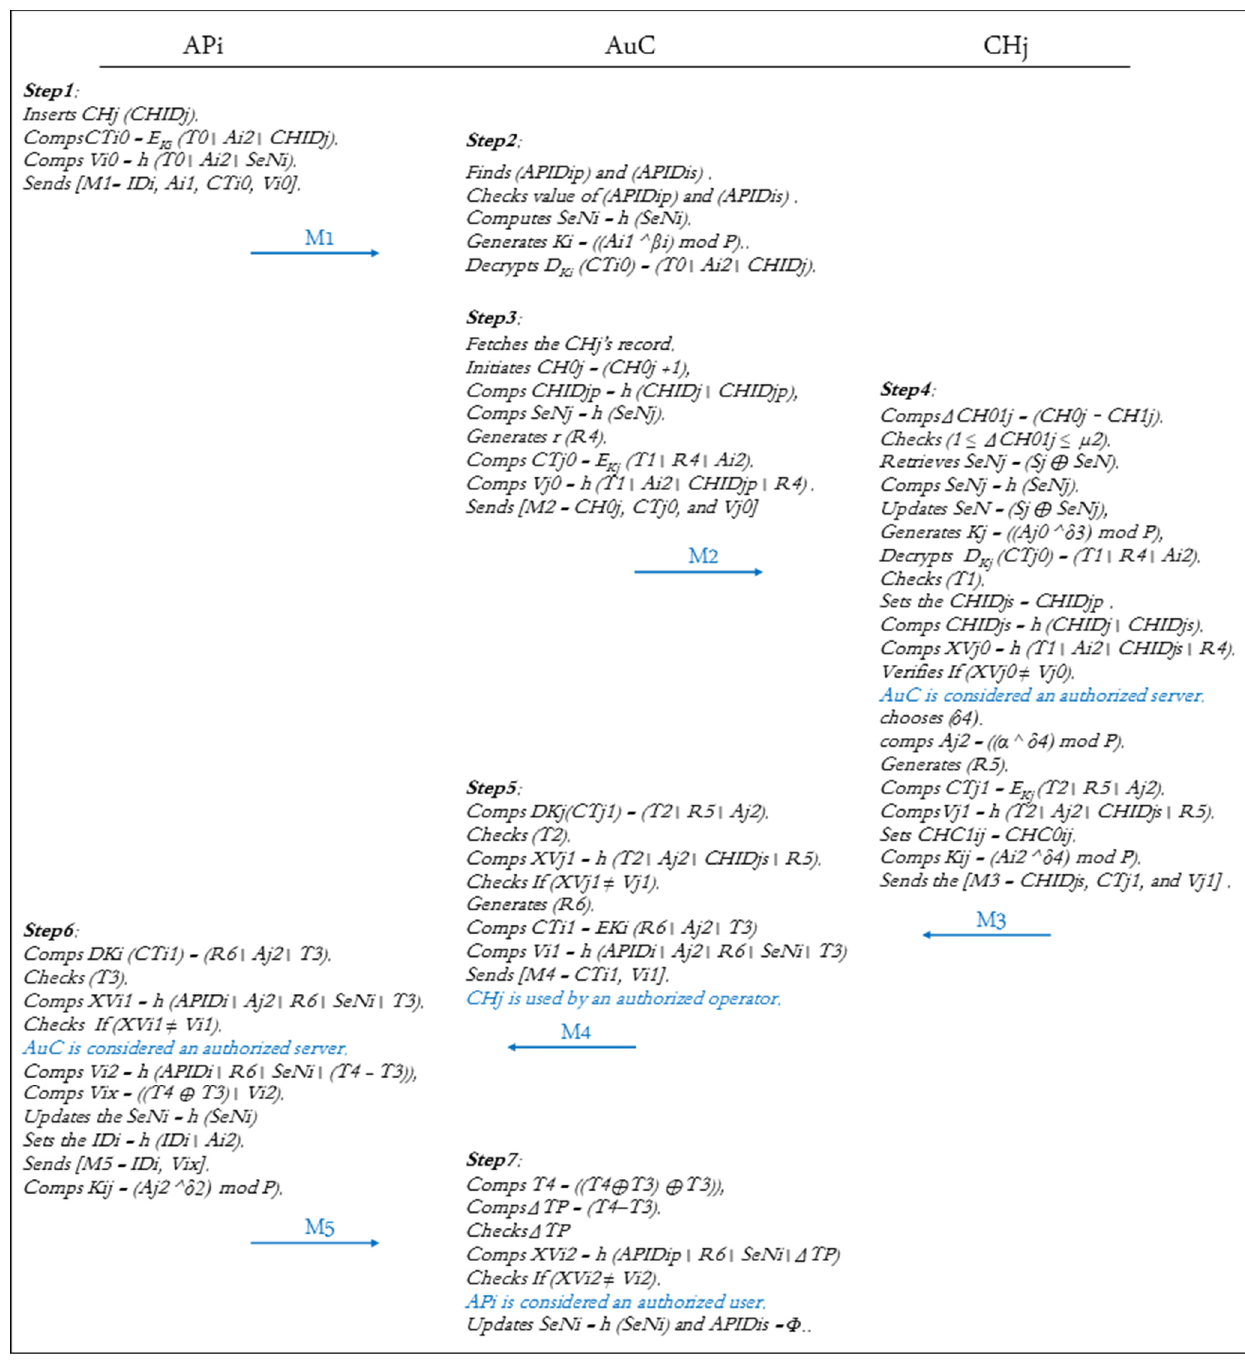
Figure 2. Authentication and session key agreement phase.